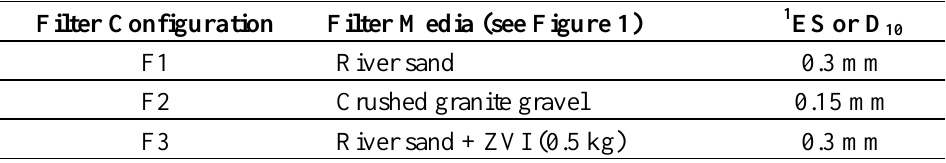
Table 1. Characteristics of filter challenge